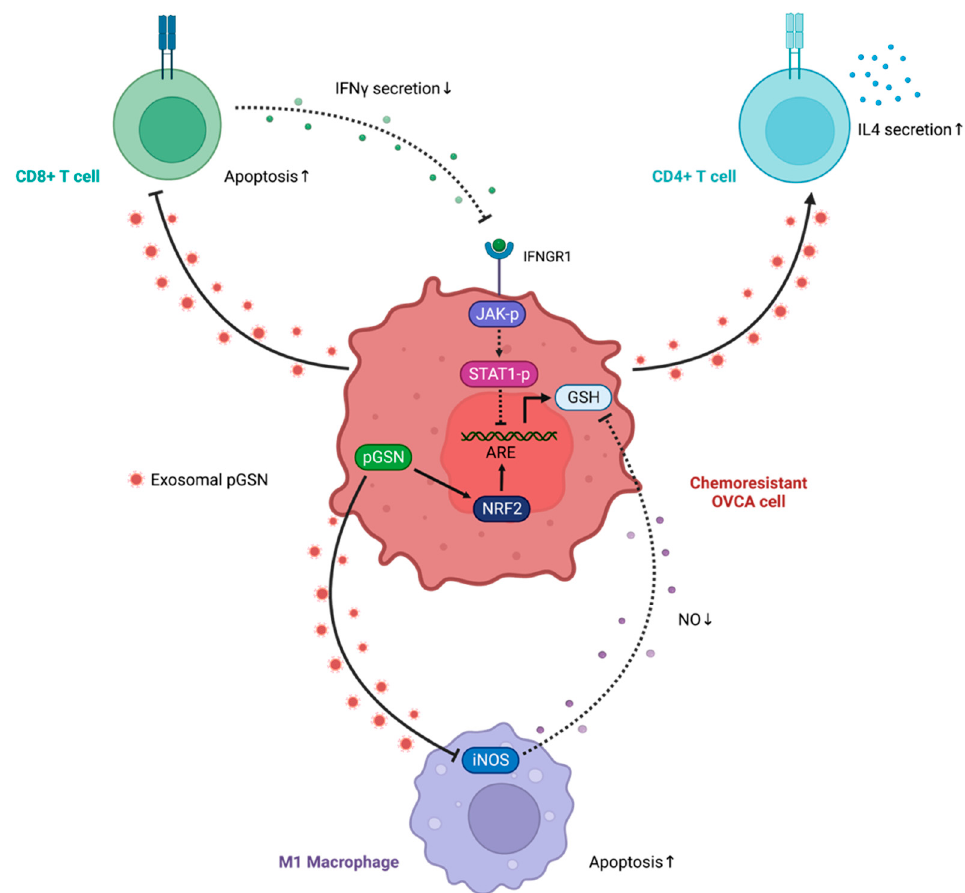
Figure 4. Immune dysfunction induced by pGSN. A chemoresistant ovarian cancer cell-derived exosomal pGSN causes CD8+ T cells to undergo apoptosis via caspase-3 activation. Apoptosis is not induced in CD4+ T cells by pGSN. CD4+ T cells secreted more IL-4, polarized to type 2 helper cells. IFN γ activates the IFNGR1/JAK/STAT1 pathway, decreasing the intracellular GSH levels. pGSN depletes CD8+ T cells and reduces IFN γ secretion. Thus, GSH production in ovarian cancer was increased and contributes to chemoresistance. Exosomal pGSN induces caspase-3 activation and apoptosis of M1 macrophages, which leads to decreased iNOS secretion. Furthermore, pGSN increases GSH content in ovarian cancer cells via decreased iNOS production in M1 macrophages, contributing to chemotherapy resistance. Abbreviations: pGSN, plasma gelsolin; IL-4, interleukin 4; IFN γ , Interferon gamma; IFNGR1, interferon gamma receptor 1; JAK, janus kinase; STAT1, signal transducer and activator of transcription 1; GSH, glutathione; iNOS, inducible nitric oxide synthase. Figure designed using